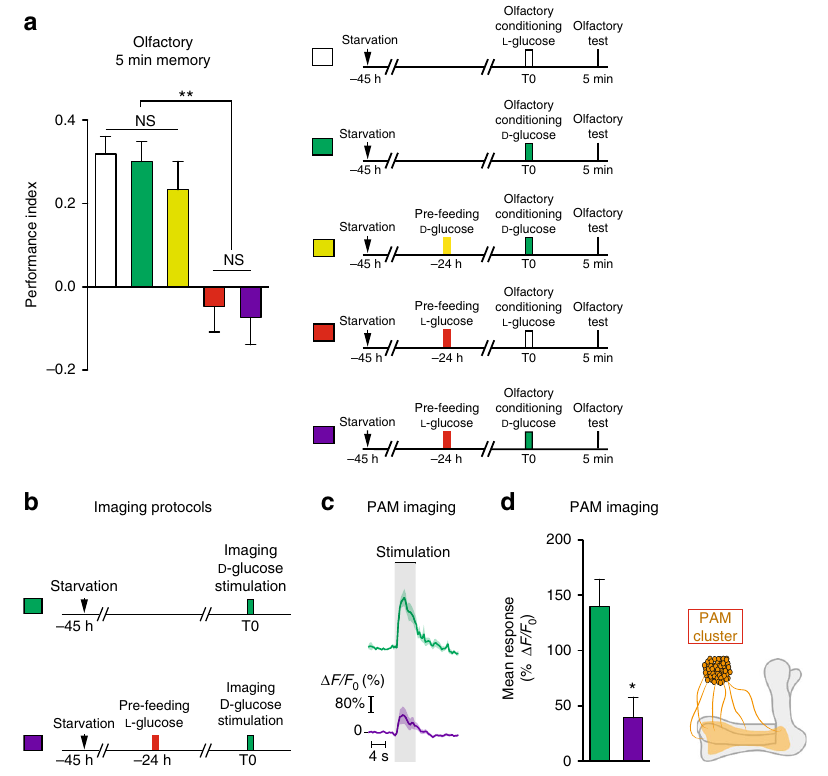
Fig. 5 NAS pre-feeding devalues caloric sugar. a Pre-feeding fl ies for 1 min with non-nutritious L -glucose 24 h before olfactory conditioning with the same sugar or the energetic D -glucose induces signi fi cantly lower STM scores as compared to controls ( F (4,55) = 12.63; p < 0.0001; n ≥ 11; p = 0.999 in post hoc comparison between fl ies not pre-fed and conditioned with L -glucose and fl ies not pre-fed and conditioned with D -glucose, p = 0.920 in post hoc comparison between fl ies not pre-fed and conditioned with L -glucose and fl ies pre-fed and conditioned with D -glucose, p = 0.829 in post hoc comparison between fl ies not pre-fed and conditioned with D -glucose and fl ies pre-fed and conditioned with D -glucose, p = 0.997 in post hoc comparison between fl ies pre-fed and conditioned with L -glucose and fl ies pre-fed with L -glucose and conditioned with D -glucose). b Pre-feeding protocol used before the imaging experiment: fl ies were pre-fed or not with L -glucose for 1 min, 24 h before D -glucose stimulation under the microscope. c Time course response of PAM neurons. n = 10. Black bar: stimulus presentation. d Average response to L -glucose. Flies pre-fed with L -glucose displayed a signi fi cantly lower response to caloric D -glucose in comparison to non-pre-fed fl ies ( t -test, t 18 = 3.264; p = 0.004; n = 10). Means are ± SEM; statistical tests: t -test and one-way ANOVA; NS: p ≥ 0.05; * p < 0.05; ** p < 0.01 in comparison between two groups for t -test and in post hoc comparisons with both parental controls for